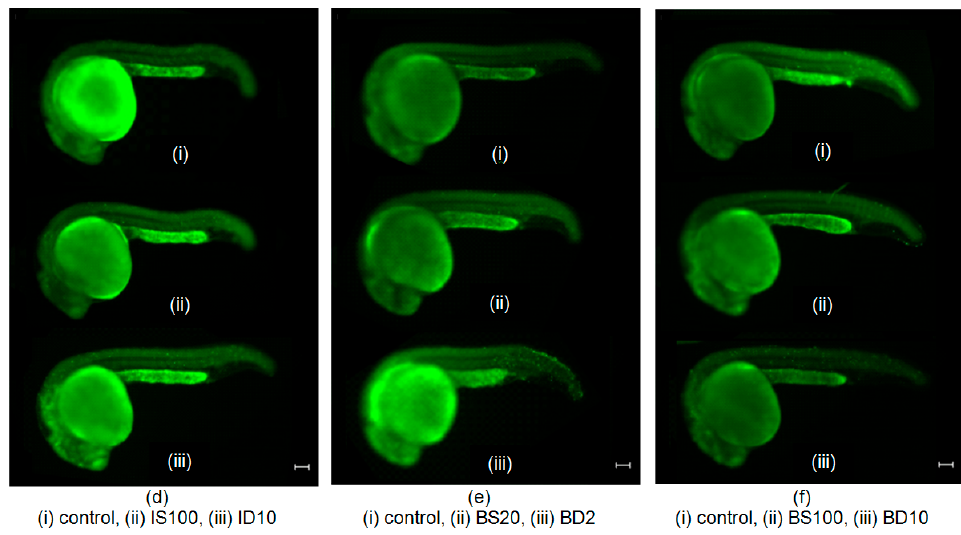
Figure 2. Representative images of acridine orange (AO)-stained embryos in different groups. ( a ) S20 group treated with 20 µM SNAP, and its experimental control D2 group; ( b ) S100 group treated with 100 µM SNAP, and its experimental control D10 group; ( c ) IS20 irradiated group treated with 20 µM SNAP, and its experimental control ID2 group; ( d ) IS100 irradiated group treated with 100 µM SNAP, and its experimental control ID10 group; ( e ) BS20 bystander group treated with 20 µM SNAP, and its experimental control BD2 group; ( f ) BS100 bystander group treated with 100 µM SNAP, and its experimental control BD10 group. ( a – f ) all corresponding control groups also shown. Images were captured using a florescent microscope with 40× magnification. Scale bar: 100 µm.